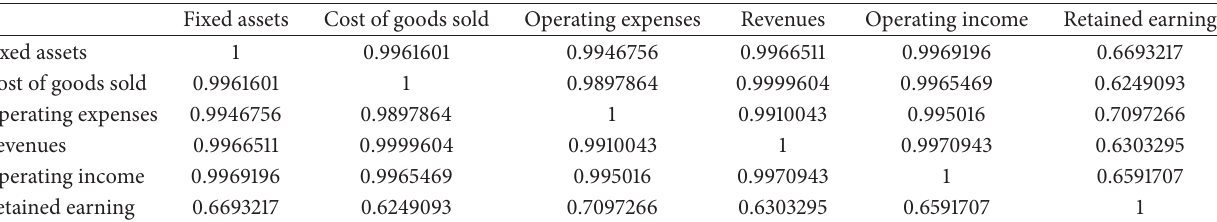
Table 8: Correlation of input and output data in 2010.